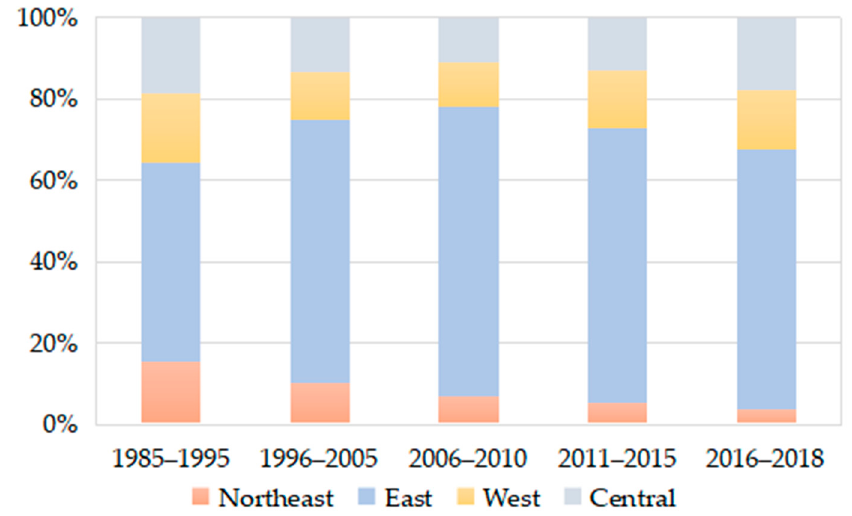
Figure 5. Regional distribution of green invention patent applications in different periods.